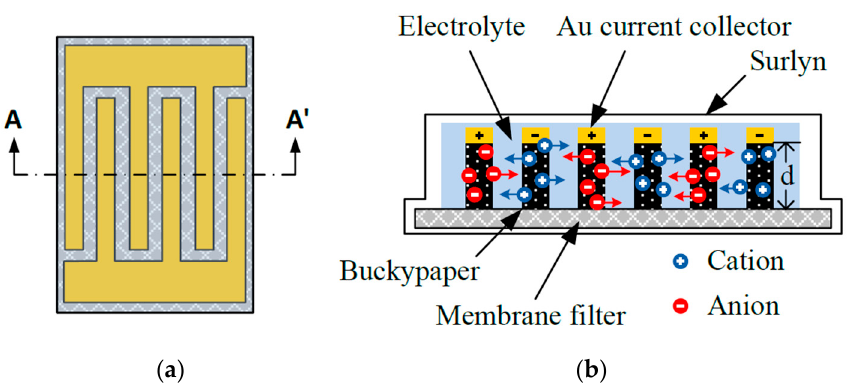
Figure 1. Schematic diagrams of the proposed micro-supercapacitors (micro-SC): ( a ) top-view; and ( b ) cross-sectional view of A-A’.